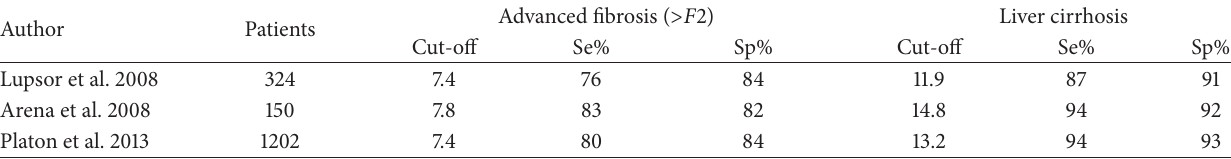
Table 1: Performance of transient elastography for detection advanced fibrosis and liver